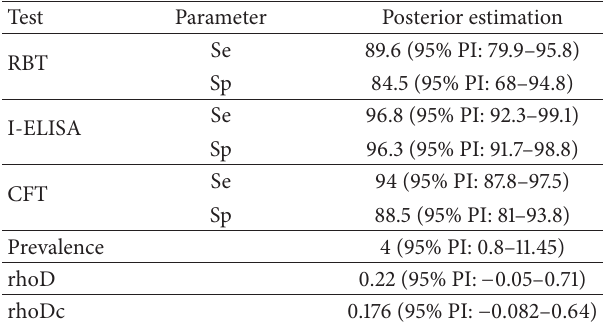
Table 3: Observed estimate of sensitivities and